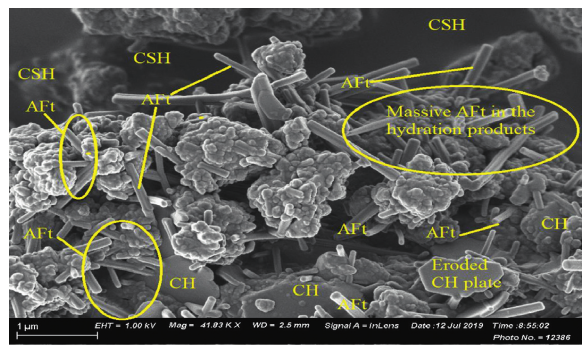
Figure 4: SEM image (iv) PPC (AT).